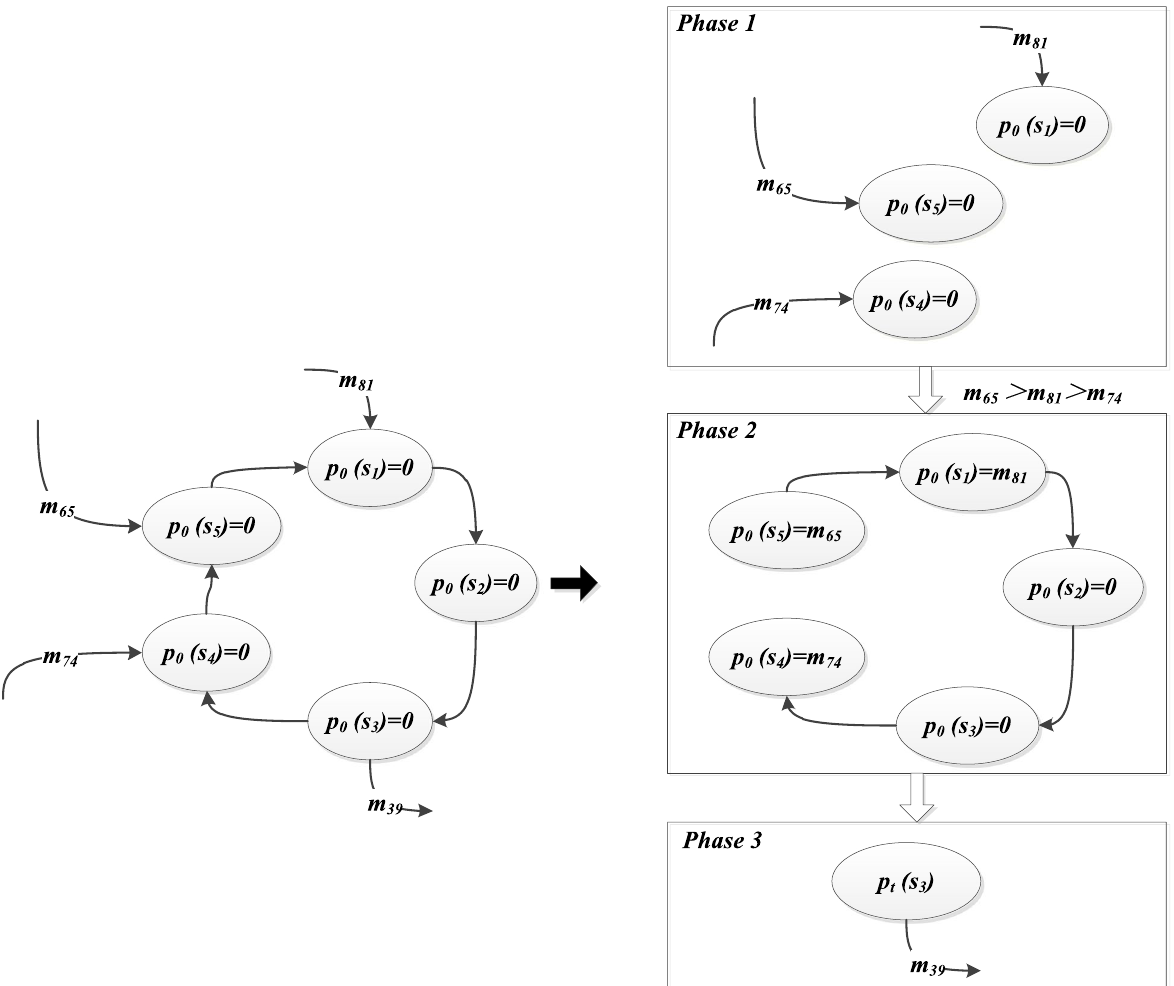
Fig. 5 No nodes of the loop are changed